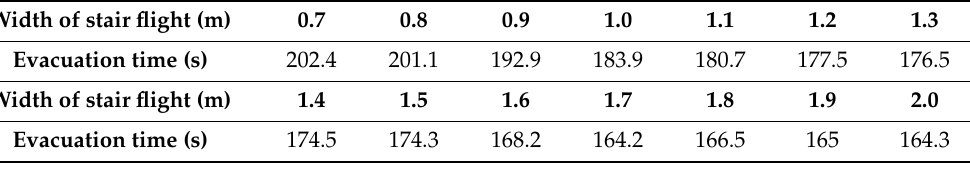
Table 5. Width of stair flight and evacuation time.